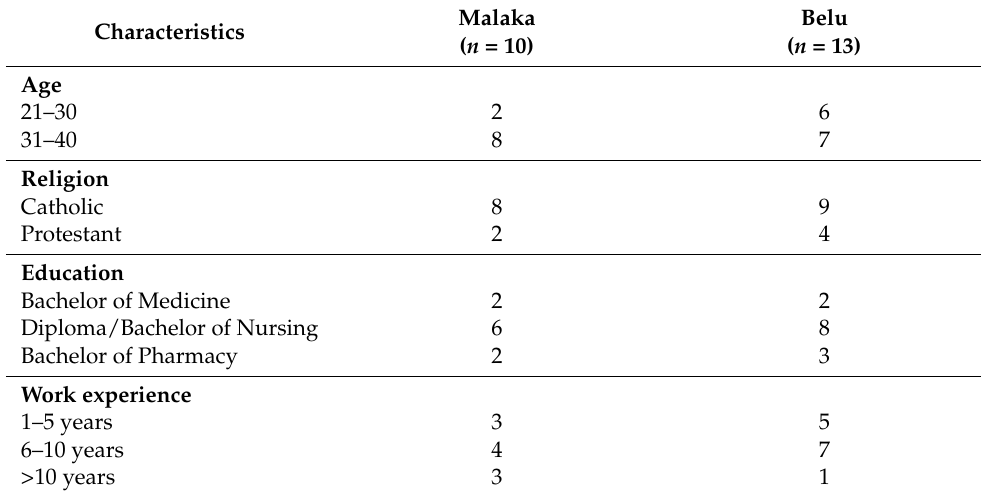
Table 2. Sociodemographic profile of the